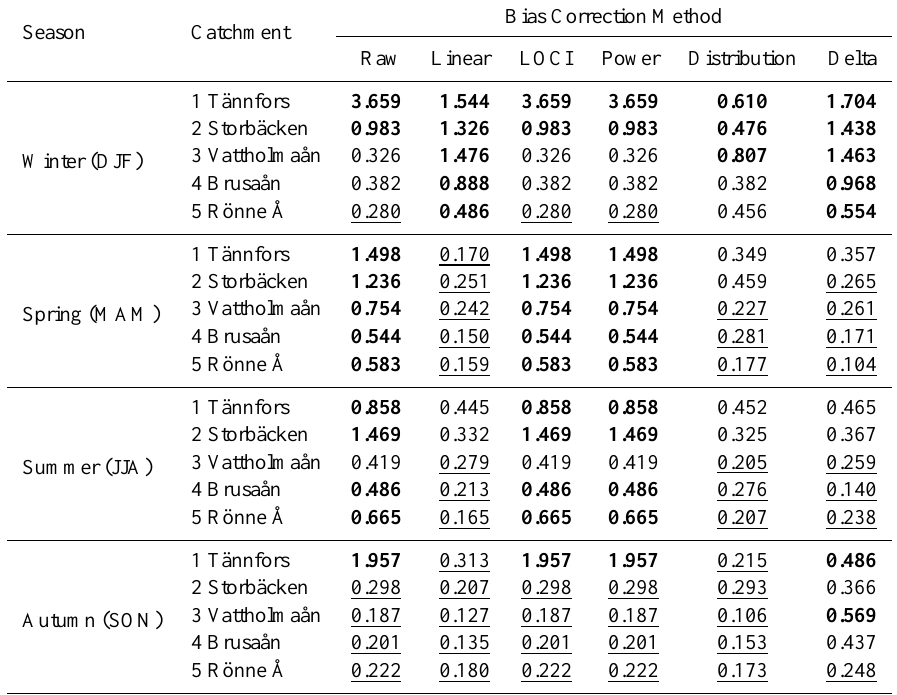
Table 7. MAE of seasonally averaged temperature [ ◦ C] of differently corrected ERA40-driven RCM simulations compared to observed seasonally averaged temperature for case-1 evaluation. Larger MAE values are shown in bold, medium MAE values appear in regular font and smaller MAE values are